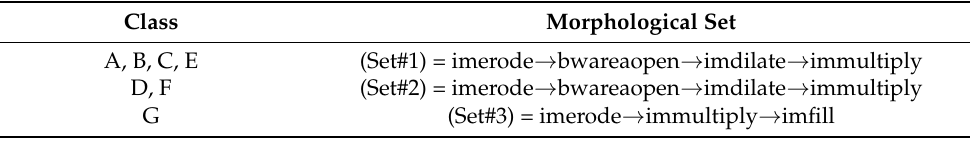
Table 3. Morphological operations (listed as MATLAB commands [35]) performed on each class, except H (no skin). Note: although the first two rows use the same set of operators, the disks employed as structuring elements have different sizes.